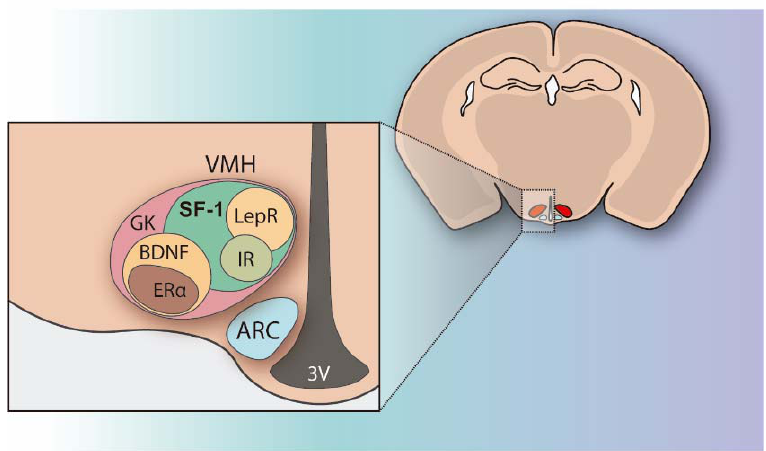
Figure 1. Schematic illustration of the pattern of genes highly expressed in the VMH. The majority of VMH cells, especially in the dorsomedial and central regions of VMH, express the nuclear receptor steroidogenic factor 1 (SF1). Leptin receptor (LEPR) positive cells mainly converge in the dorsomedial part, whereas insulin receptor (IR) maps the central region. Cells expressing brain-derived neurotrophic factor (BDNF) are mainly distributed in central and lateral areas of the VMH, estrogen receptor (ER α )-expressing cells are limited to the lateral region, and glucokinase (GK)-positive cells are present throughout the VMH. This schematic diagram is based on previous articles from Choi et al. [8] and Yi et al. [6].